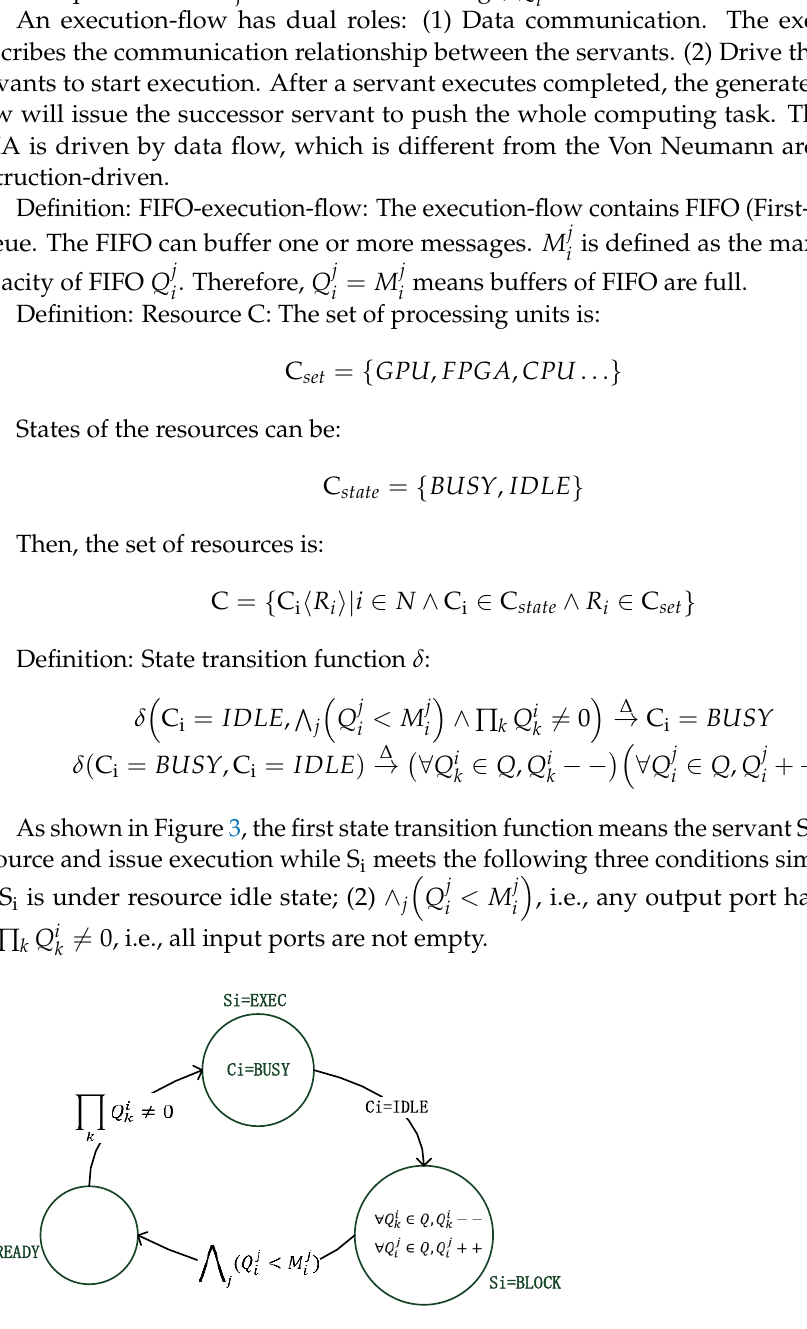
Figure 3. States transition of servant.